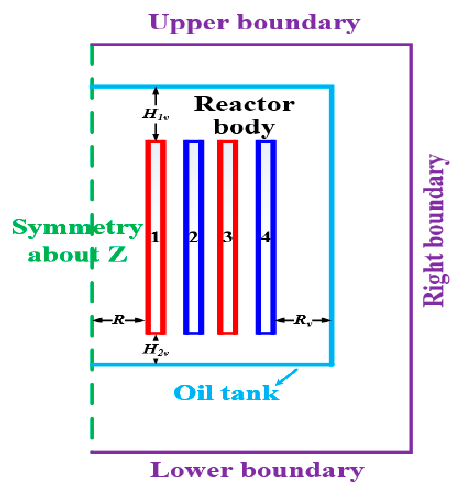
Figure 6. The equivalent model of the oil tank and reactor body.